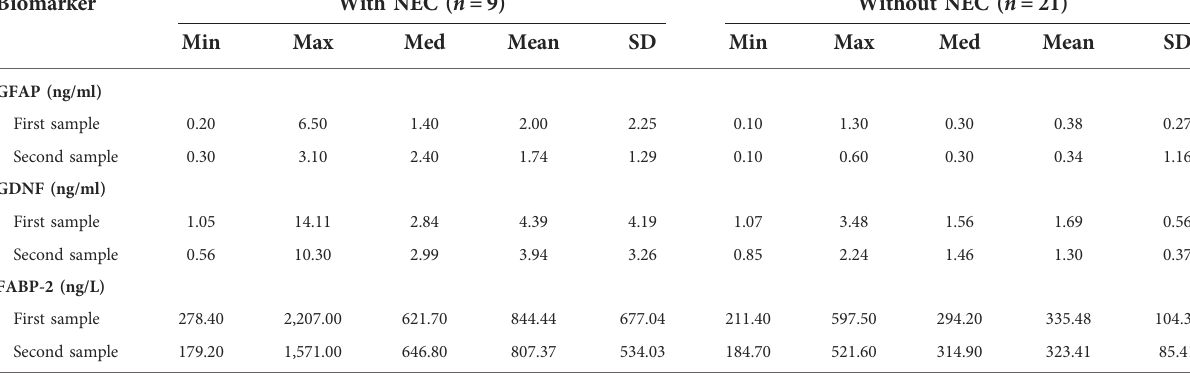
TABLE 3 Description of biomarkers in the group of infants with NEC and without